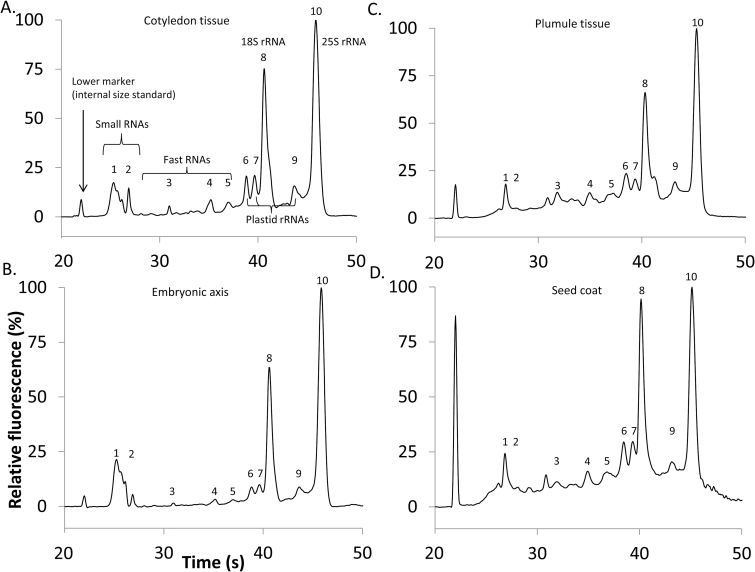
Representative electropherograms from dry tissues of soybean seeds harvested in 2014 showing exemplary RNA quality, transformed to show the percentage of maximum fluorescence for that sample. (A) Cotyledon tissue, extracted with the modified MMY method; RIN=8.1. (B) Embryonic axis, extracted with the modified MMY method; RIN=9.2. (C) Plumule tissue, extracted with the Qiagen RNeasy kit; RIN=7.3. (D) Seed coat, extracted with the Qiagen RNeasy kit; RIN=6.9.